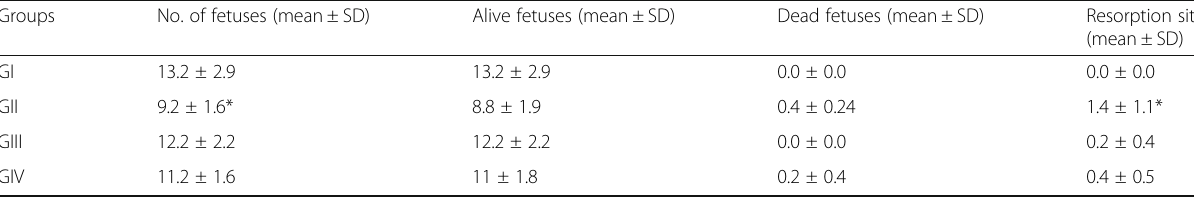
Table 3 Effects of olive leaf extract and/or STZ administration on the reproductive outcome